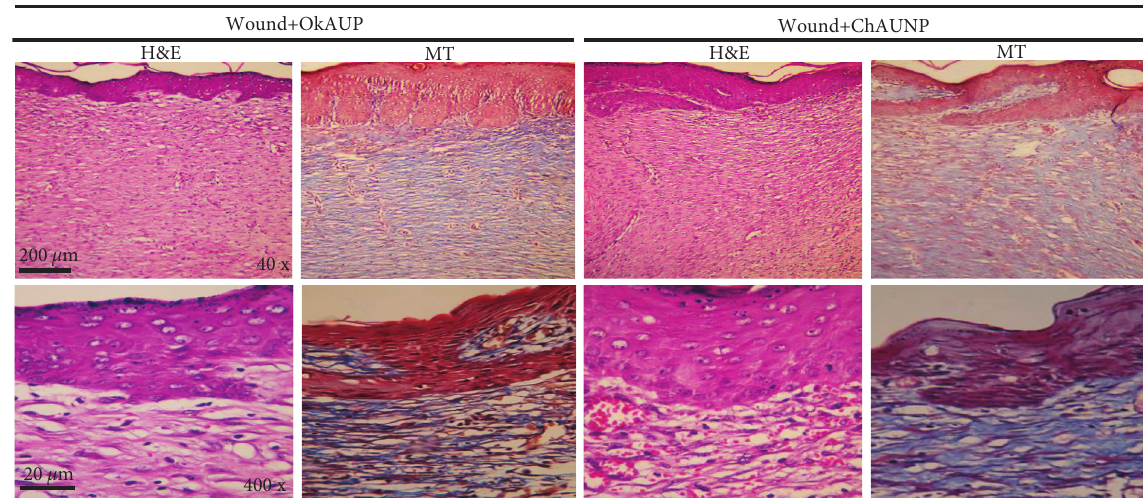
Figure 12: Histopathological images of the skin from the different groups with hematoxylin and eosin (H&E) and Masson’s trichrome (MT) staining: the wound groups treated with the Ok Au NPs and the Ch Au NPs in which there was an improvement in the tissue